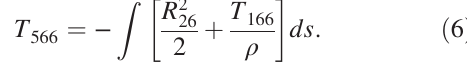
FIG. 6. Optics and first-, second- and third-order horizontal and longitudinal dispersion functions of the existing MAX IV BC1.